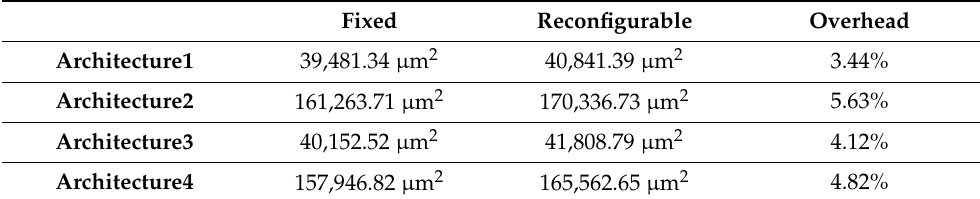
Table 3. Overhead of reconfigurable architecture.